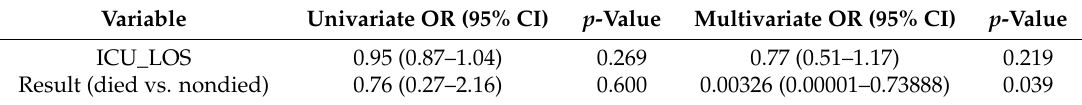
Table 3. Logistic regression analysis of risk